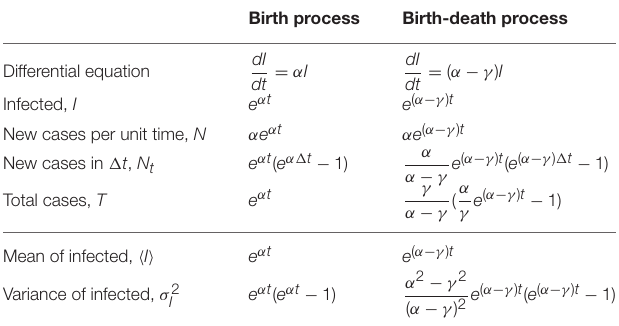
TABLE 2 | Number of infected, new cases and total cases for the birth and the birth-death processes as defined in the deterministic (top part of the table) and stochastic (bottom part)